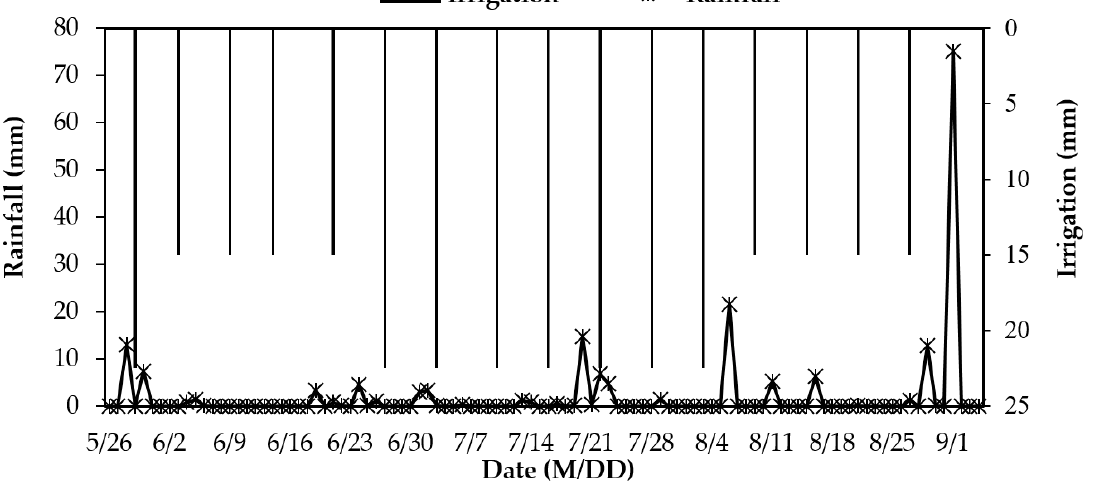
Figure 2. Irrigation and rainfall during the spring maize growth period in 2018.